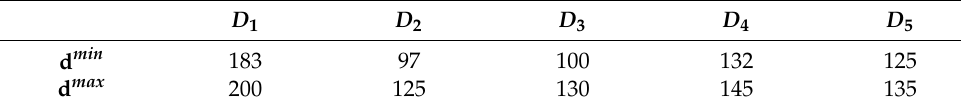
Table 10. The minimum and maximum SMD number of pieces.